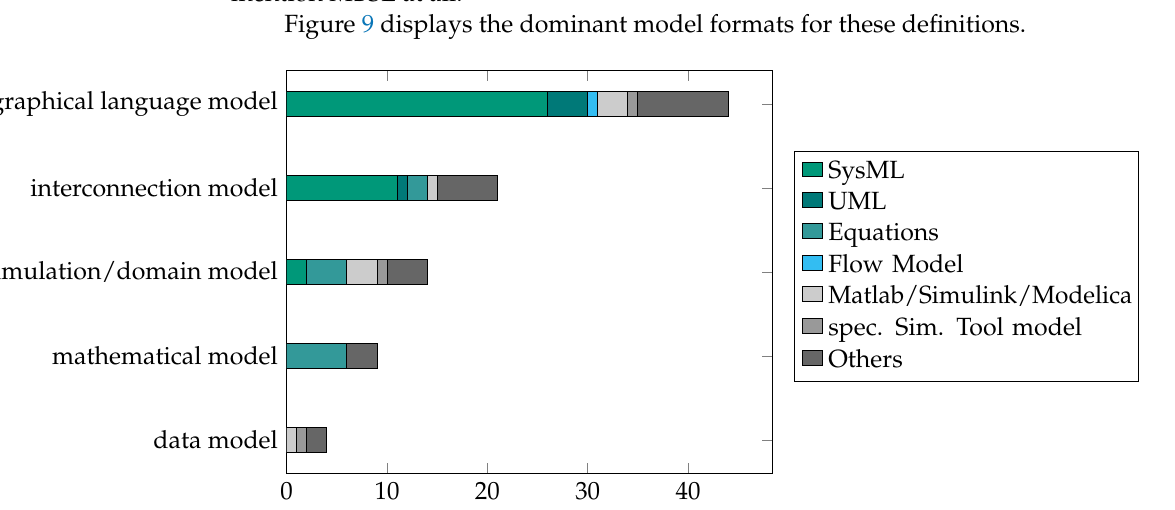
Figure 9. Number of model types per definition in literature body (multiple assignments